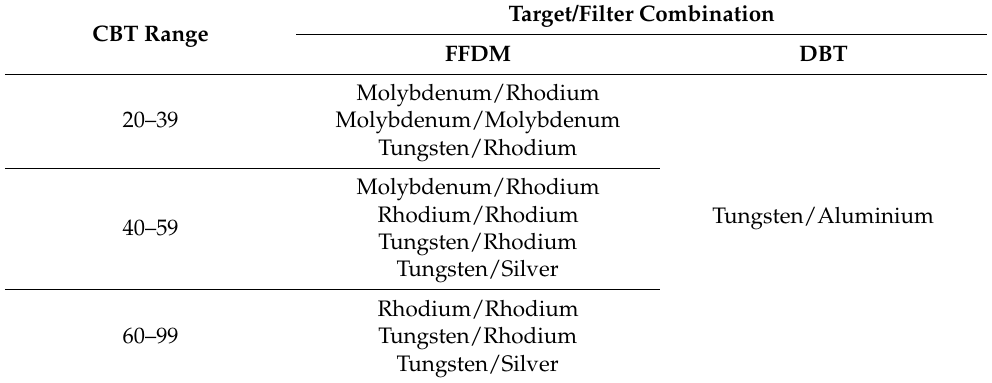
Table 1. The target/filter combination for each breast thickness range and mammographic